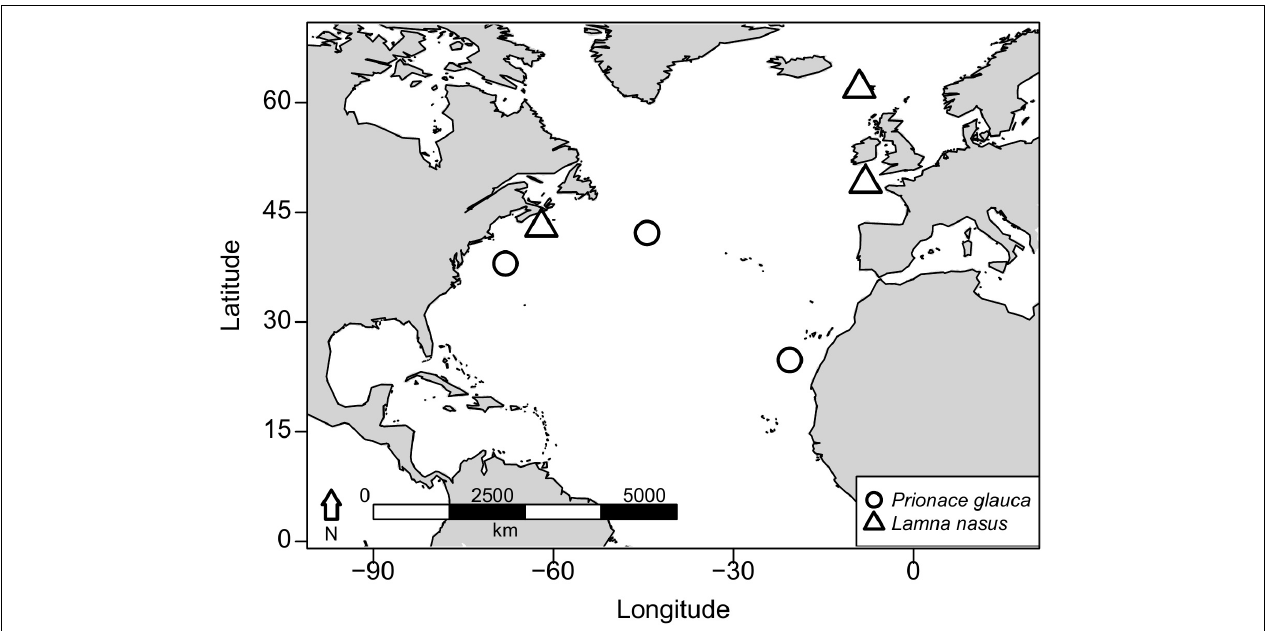
FIGURE 1 | Capture areas for blue sharks ( Prionace glauca ) and porbeagles ( Lamna nasus ) in the North Atlantic.